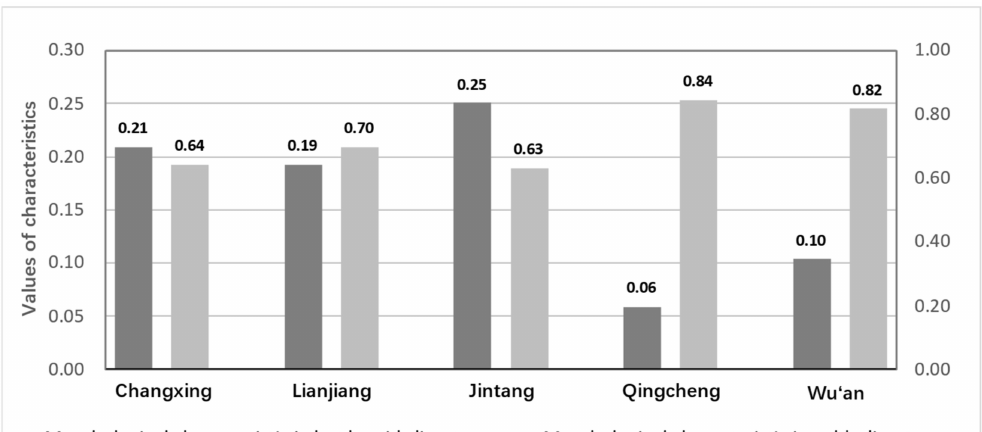
Figure 7. Evaluation results of morphological